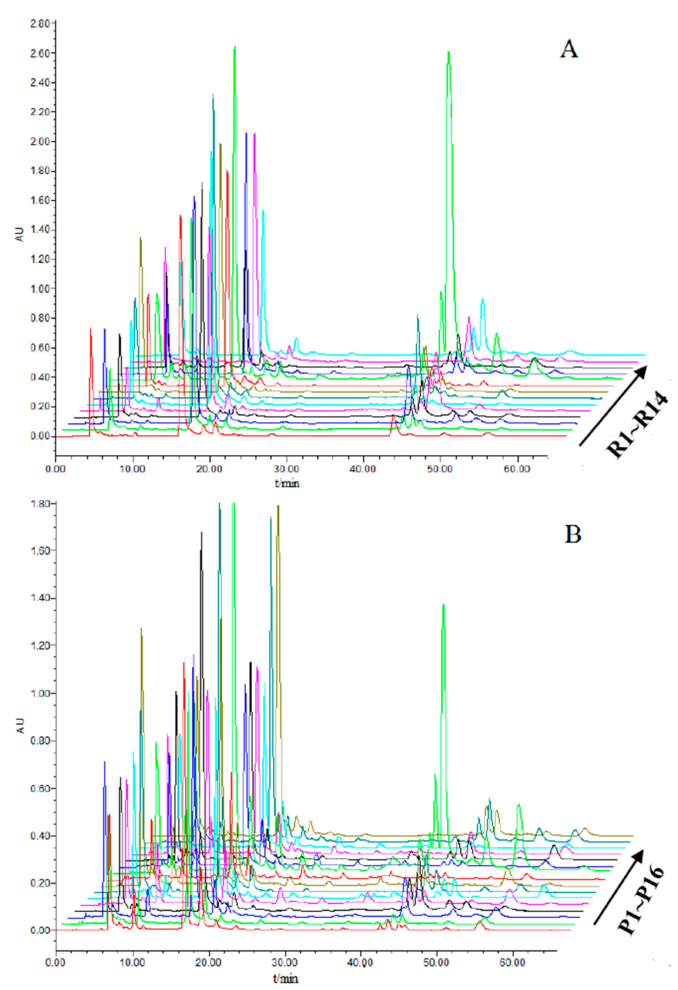
Figure 1. High-performance liquid chromatography–photodiode array detection (HPLC-PDA) fingerprints of ( A ) 14 batches of raw Xanthii Fructus (RXF) samples; and ( B ) 16 batches of processed XF (PXF) samples, at 327